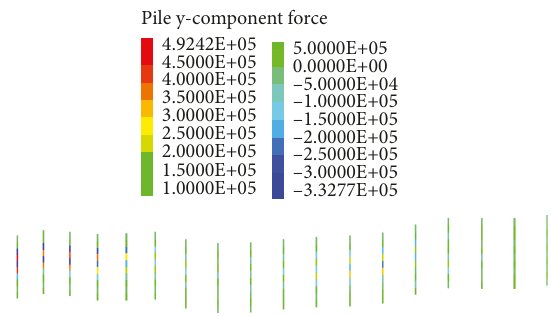
Figure 27: Pile shear force distribution under polyline